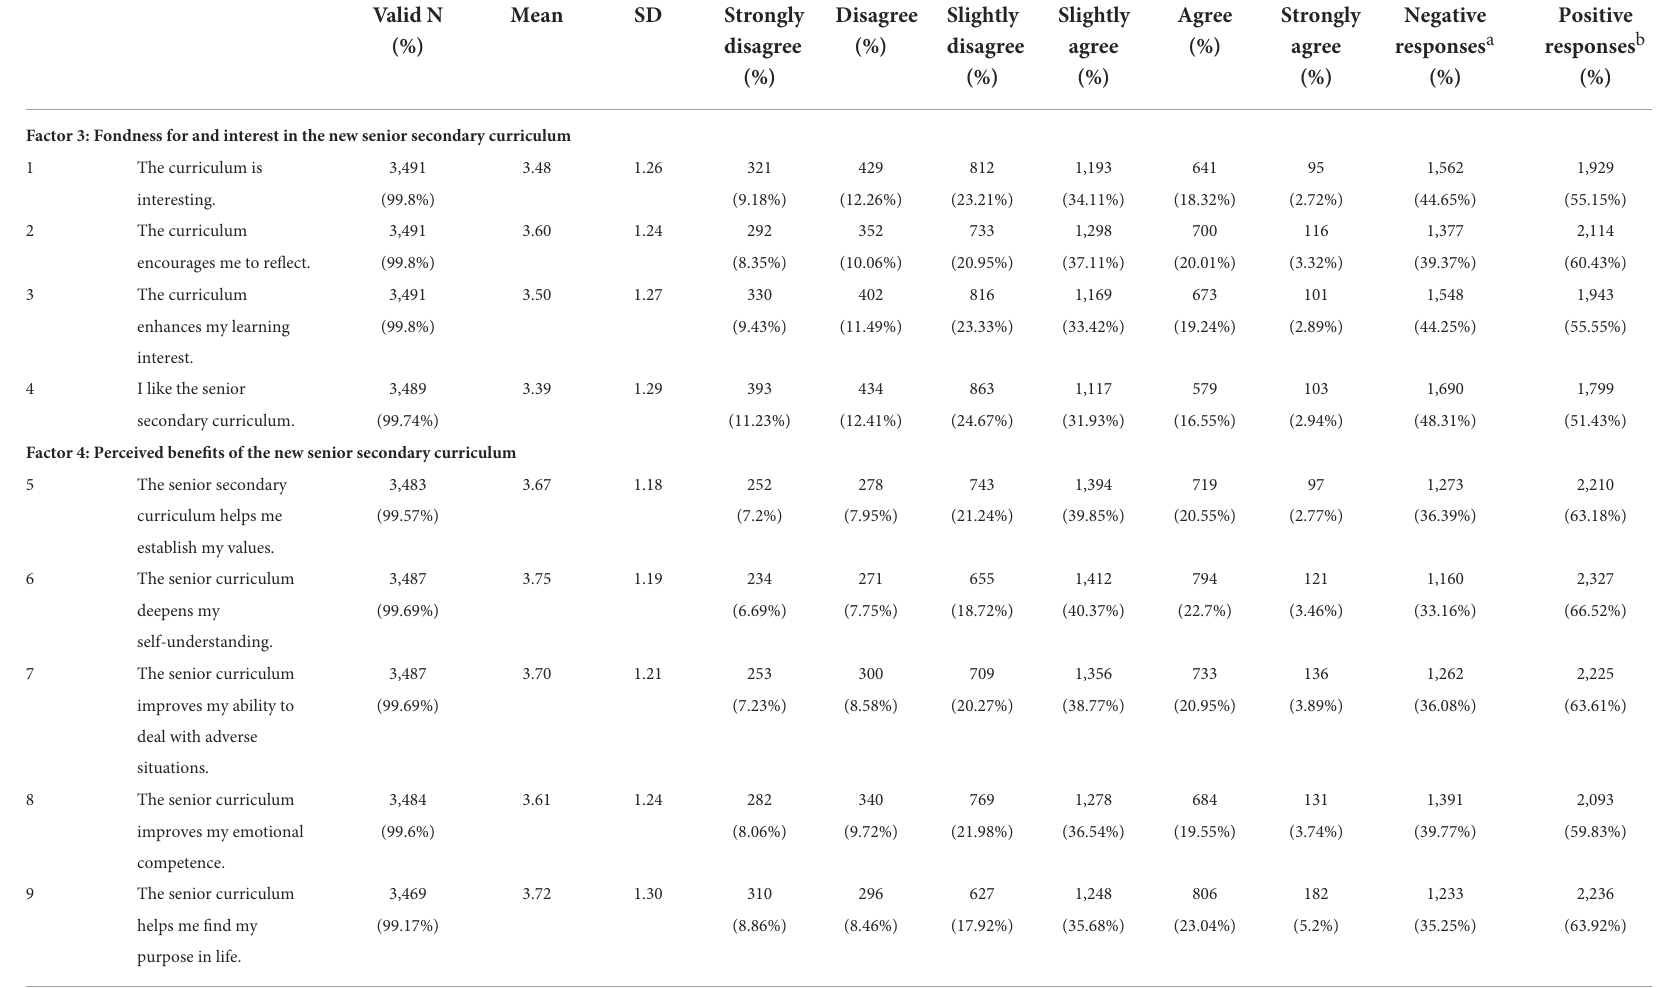
TABLE 5 Percentages of responses to the questions on academic satisfaction with the senior secondary